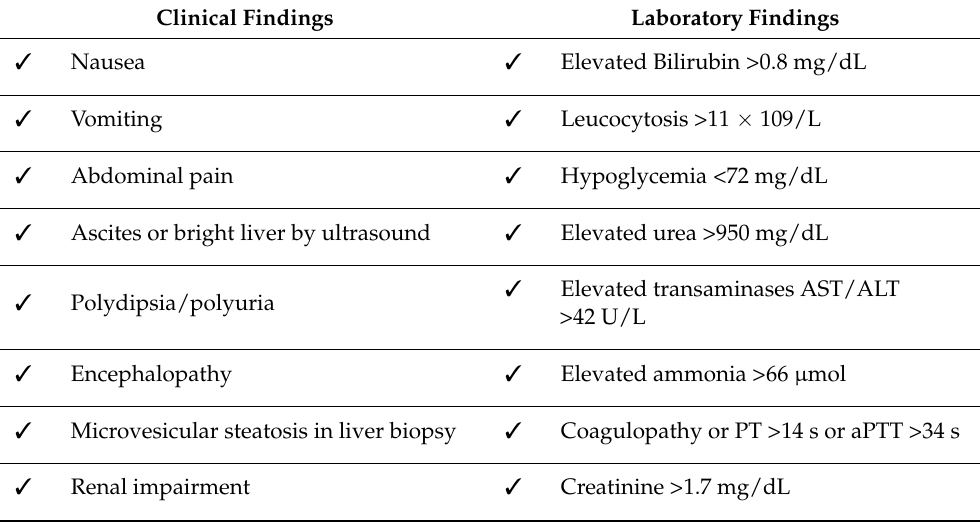
Table 7. Swansea criteria used in AFLP diagnosis. Clinical Findings Laboratory